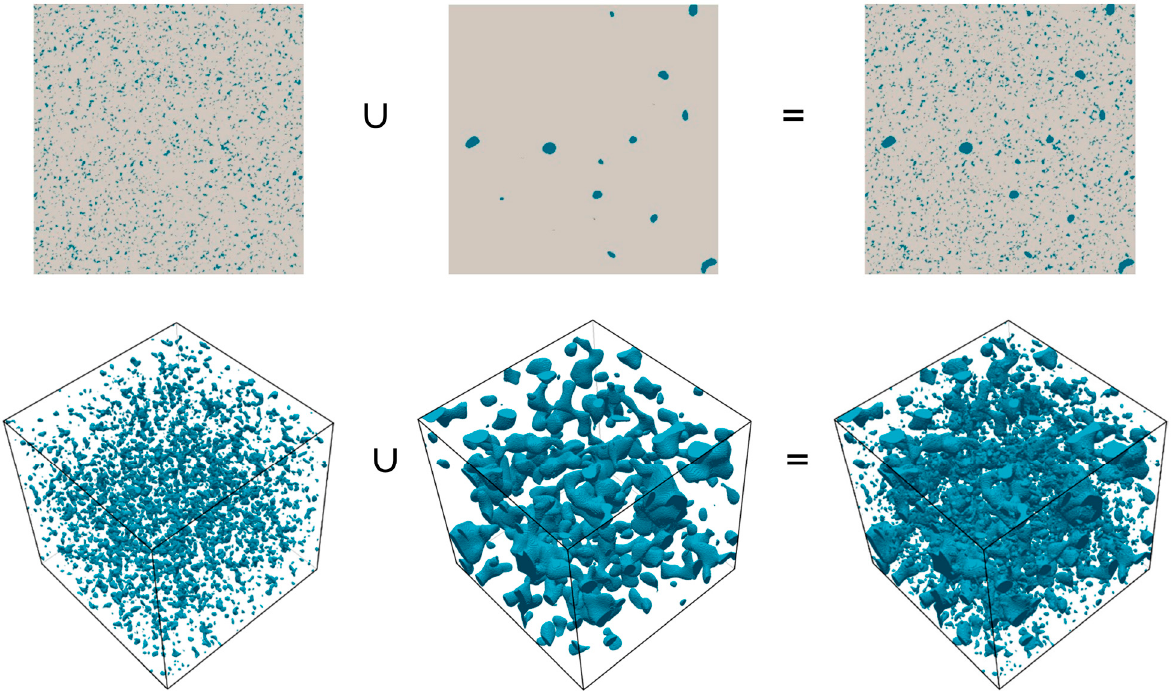
Figure 6. Combination of two fields with different 𝐿 (cid:3004) values.